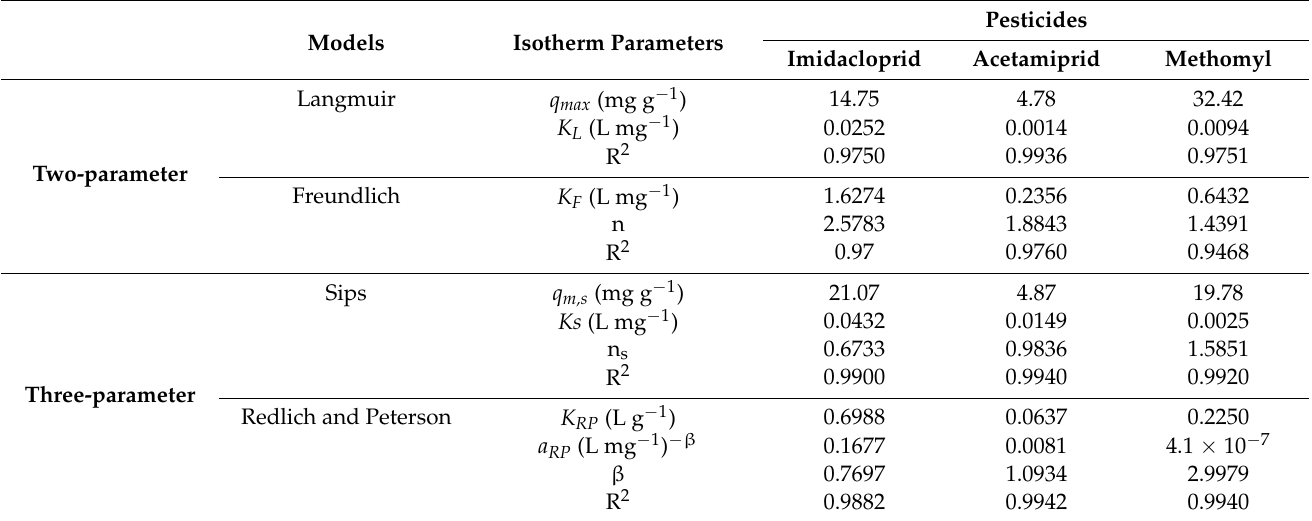
Table 4. Parameter of adsorption isotherms for imidacloprid, acetamiprid and methomyl adsorption on